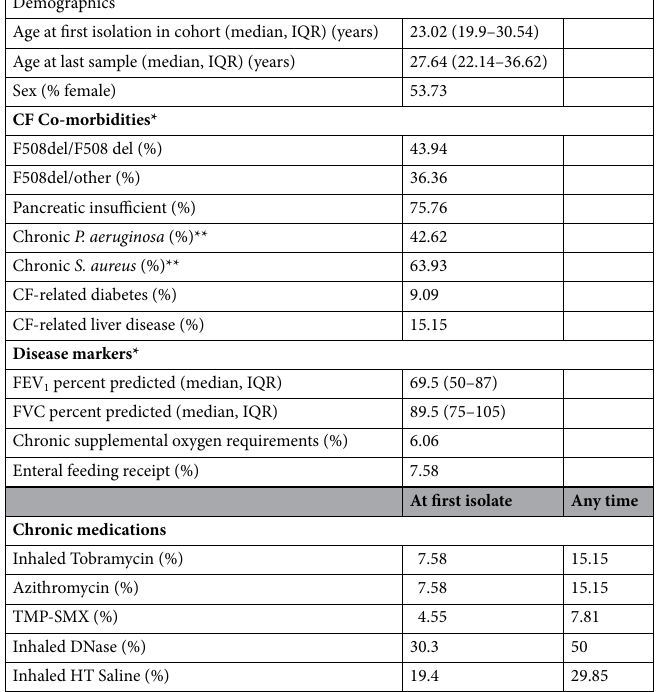
Table 1. Summary characteristics of patients with at least one isolate typed by PFGE. *Demographics at entrance into cohort. **Chronic at any